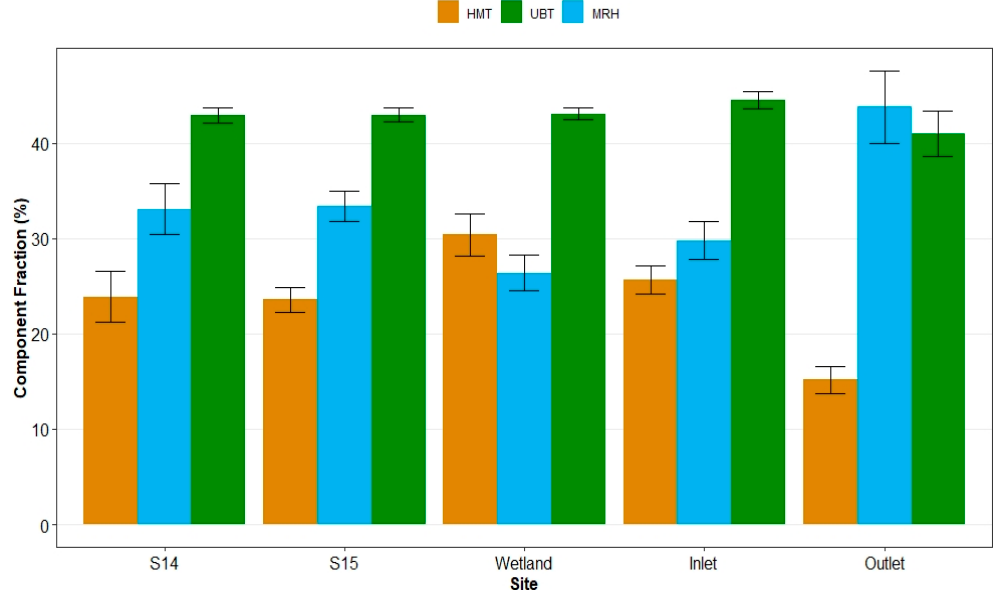
Figure 4. Distribution of mean ( + standard deviation) of DOM component fractions (HMT—high molecular weight terrestrial; UBT—ubiquitous terrestrial; MRH—microbial reprocessed humic-like materials) in surface waters at the Arbutus Lake watershed.